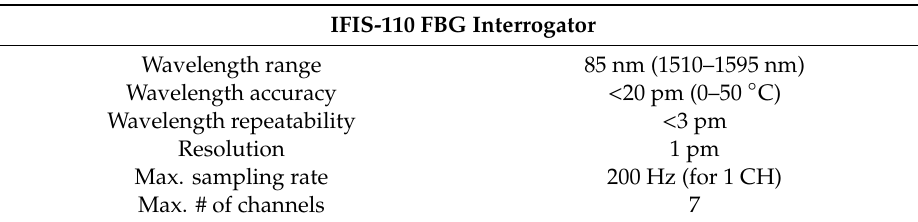
Figure 5. Schematic diagram of the experimental setup including photos of the specimen. Table 2. Specifications of an FBG interrogation system.